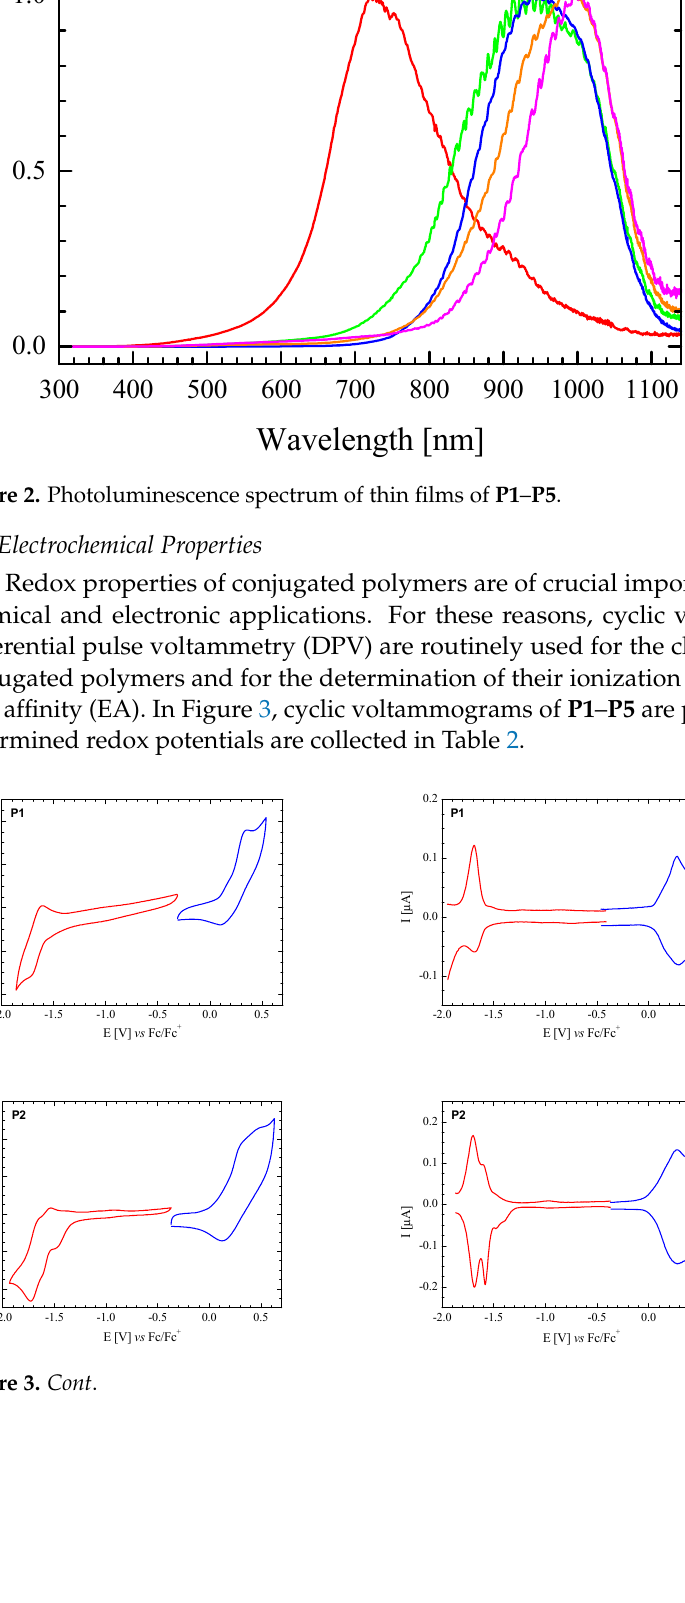
( b ) Figure 3. Cyclic voltammograms ( a ) and differential pulse voltammograms ( b ) registered for the polymers P1 – P5 dissolved in 0.1 M Bu 4 NBF 4 /dichloromethane electrolyte. CV: scan rate = 50 mV/s and DPV: modulation time = 50 ms, modulation amplitude = 10 mV, step potential = 5 mV.